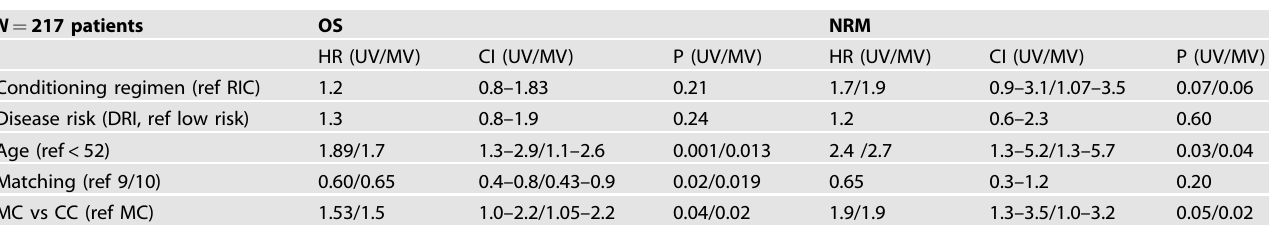
Table 2. Cox regression-factors affecting OS and NRM in all the patients (MC and CC).